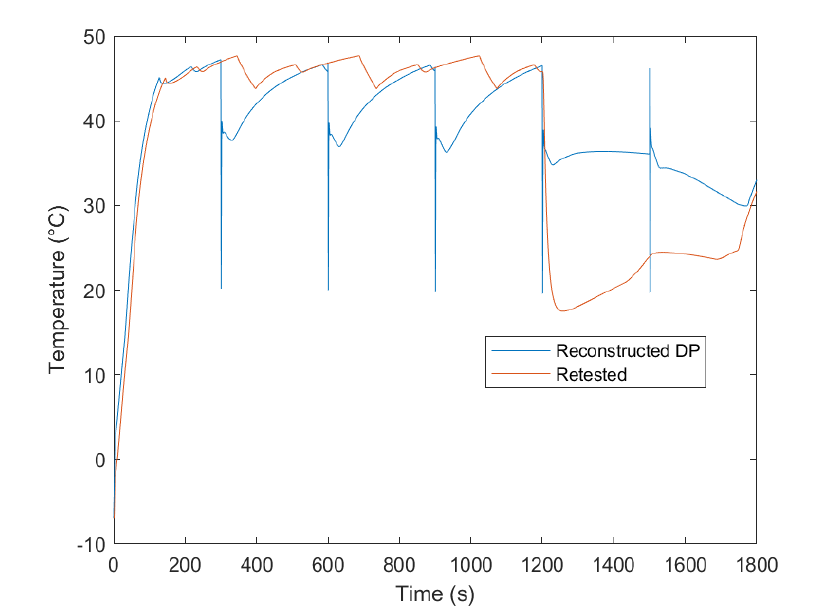
Figure 20. Heater core temperature during forward solution (labelled Reconstructed DP) and model implementation (labelled